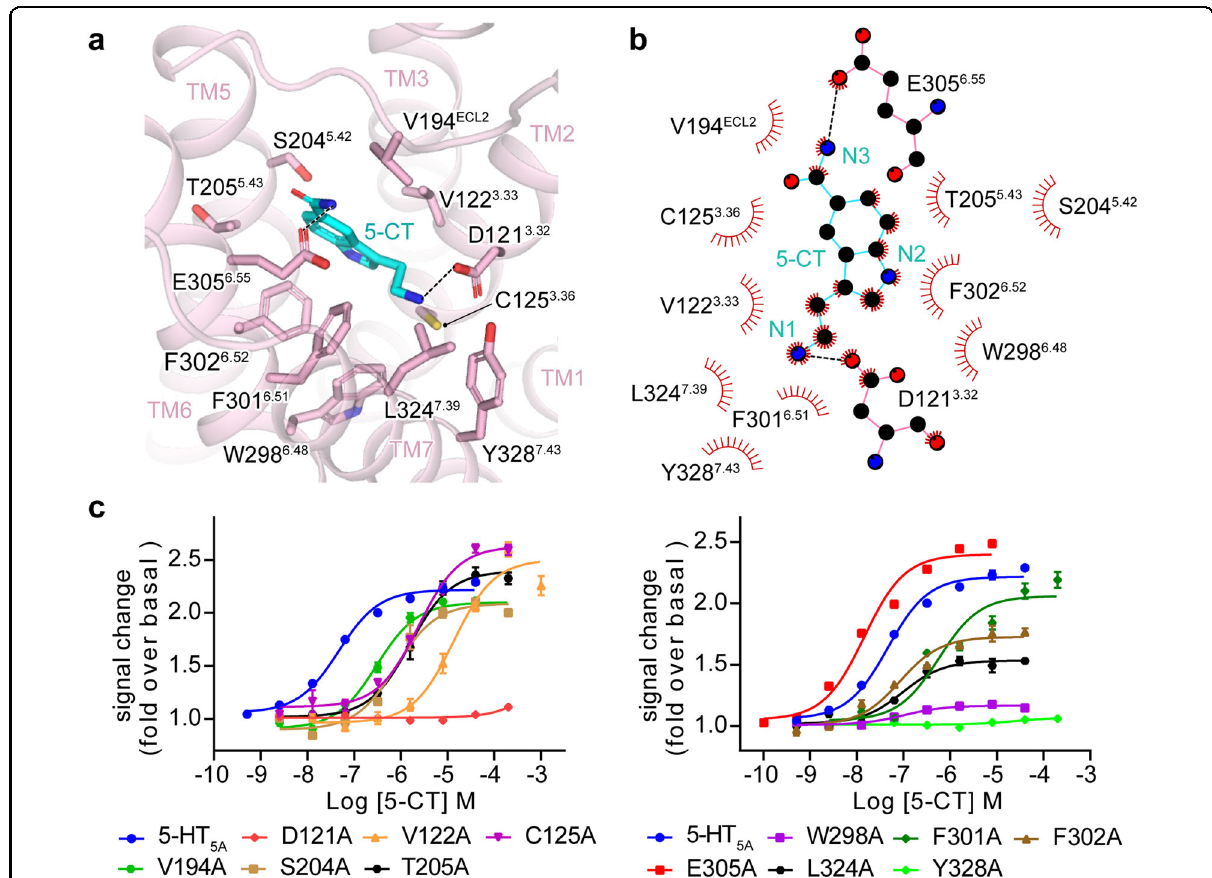
Fig. 2 The 5-CT-binding pocket of 5-HT 5A . a Detailed interactions of 5-CT with residues in the binding pocket of 5-HT 5A . b 2D schematic representation of interactions between 5-CT and residues in the ligand-binding pocket of 5-HT 5A , analyzed by LigPlot + program. The polar interactions are indicated as black dashed lines. c Effects of alanine mutation of pocket residues of 5-HT 5A on 5-CT-induced G i protein recruitment. Three independent NanoBiT assays in triplicates were performed. Each data point presents mean ± SEM from a representative